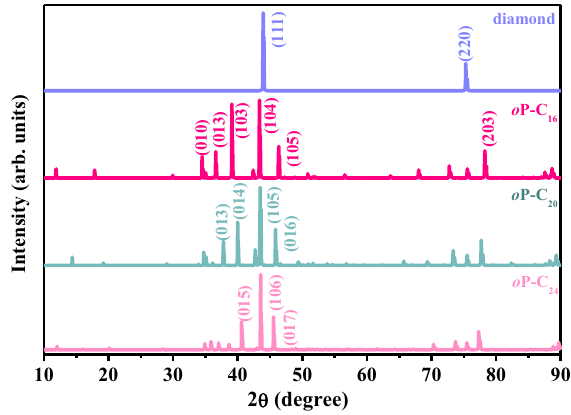
Figure 6: Simulated XRD patterns of o P - C 16 , o P - C 20 , o P - C 24 , and diamond, using an x - ray wavelength ( 1.5406 Å ) with a copper source for simulation in this